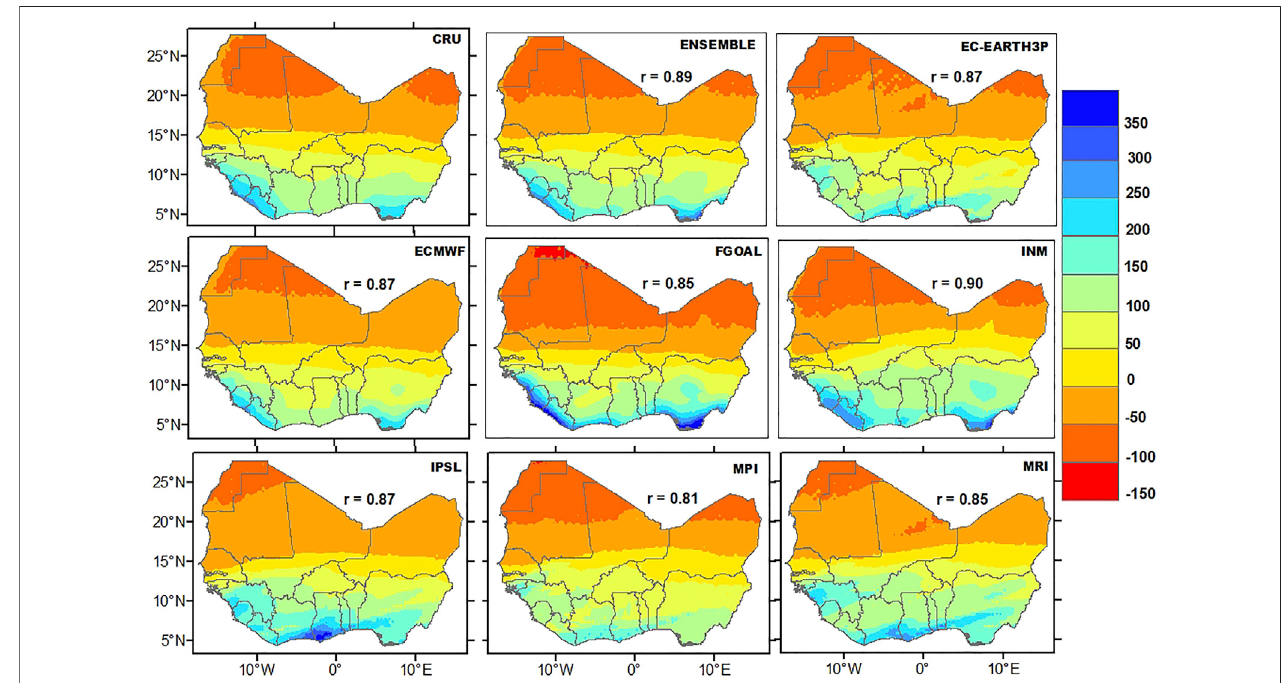
FIGURE 4 | Observed and simulated climatological distribution of climatic water availability (CWA) over West Africa during 1985 – 2014. r indicates the Pearson pattern correlation between CRU and each HighResMIP simulation.